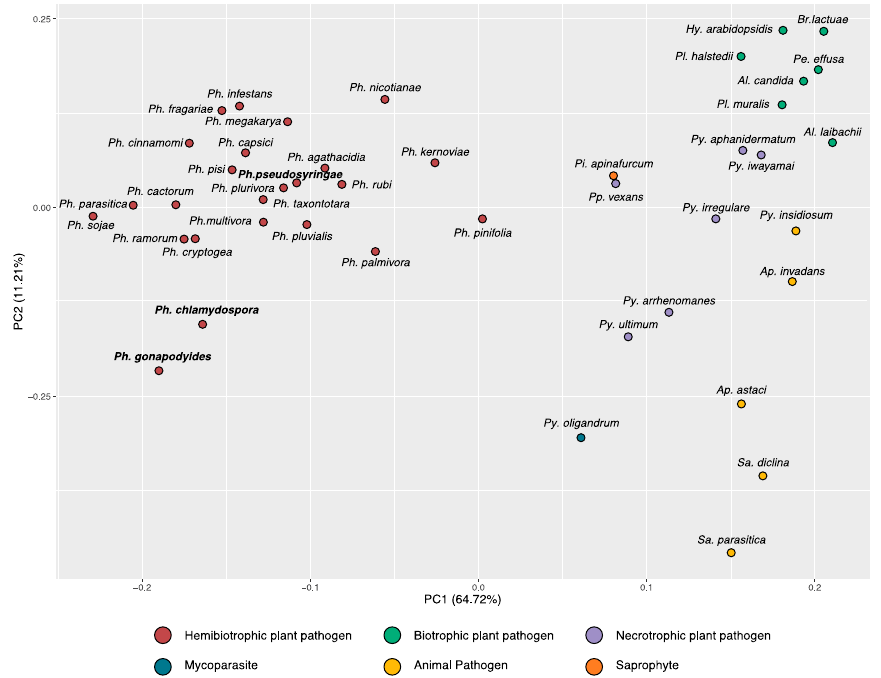
Figure 5. PCA clustering of oomycete species based on copy numbers of glycoside hydrolase families. Genus abbreviations are as follows: Albugo ( Al .), Aphanomyces ( Ap .), Bremia ( Br .), Hyaloperonospora ( Hy .), Peronospora ( Pe .), Phytophthora ( Ph .), Phytopythium ( Pp .), Pilasporangium ( Pi .), Plasmopara ( Pl .), Pythium ( Py .), Saprolegnia ( Sp .). Colored dots relate to lifestyle. Species with similar lifestyles are clustered together suggesting oomycete lifestyles may be linked to their glycoside hydrolase